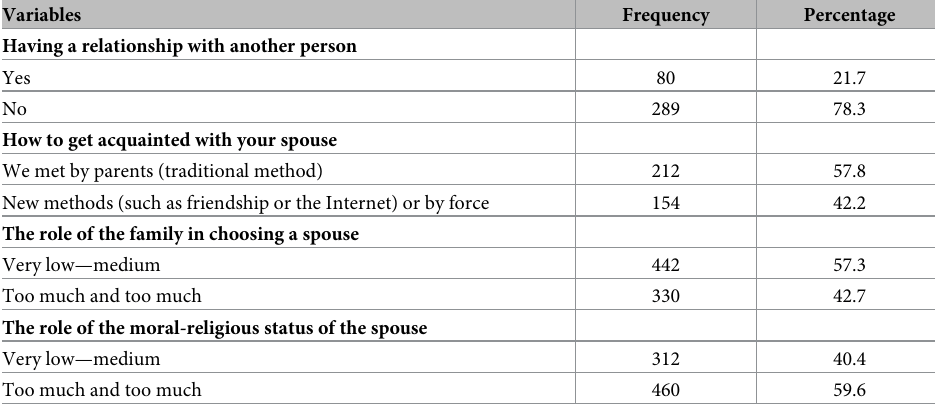
Table 2. Competing risk